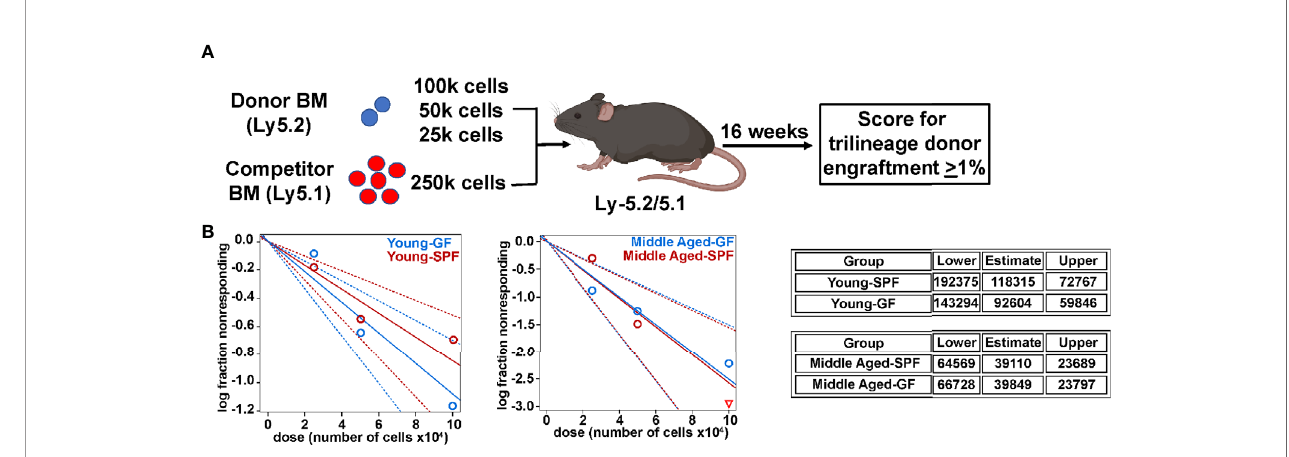
FIGURE 4 | Microbiota signals do not alter age related expansion of HSCs. (A) Limiting dilution transplantation strategy to measure frequency of functional HSCs. Created with BioRender.com. (B) Limiting dilution analysis of repopulating activity. Shown is the fraction of mice showing long-term multilineage engraftment versus dose of total bone marrow cells transplanted. The dotted lines give the 95% con fi dence interval. The table represents exact one-sided 95% con fi dence interval estimates of HSC